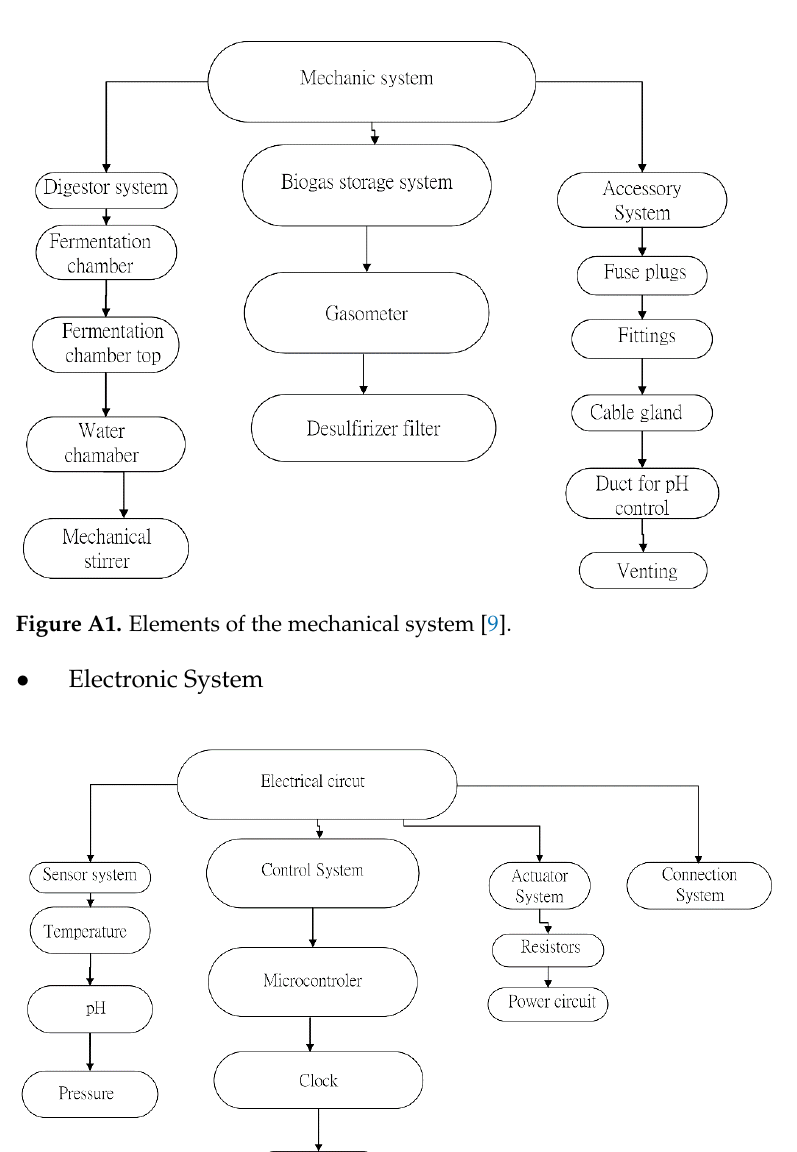
Figure A2. Elements of the electronic system [9].